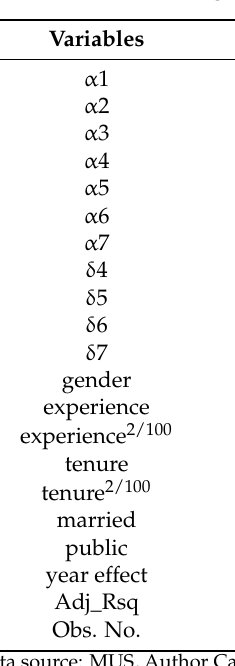
Table 3. DDD Model Regression